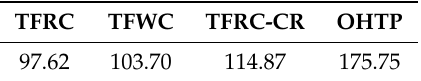
Table 3. Average Delay (ms).